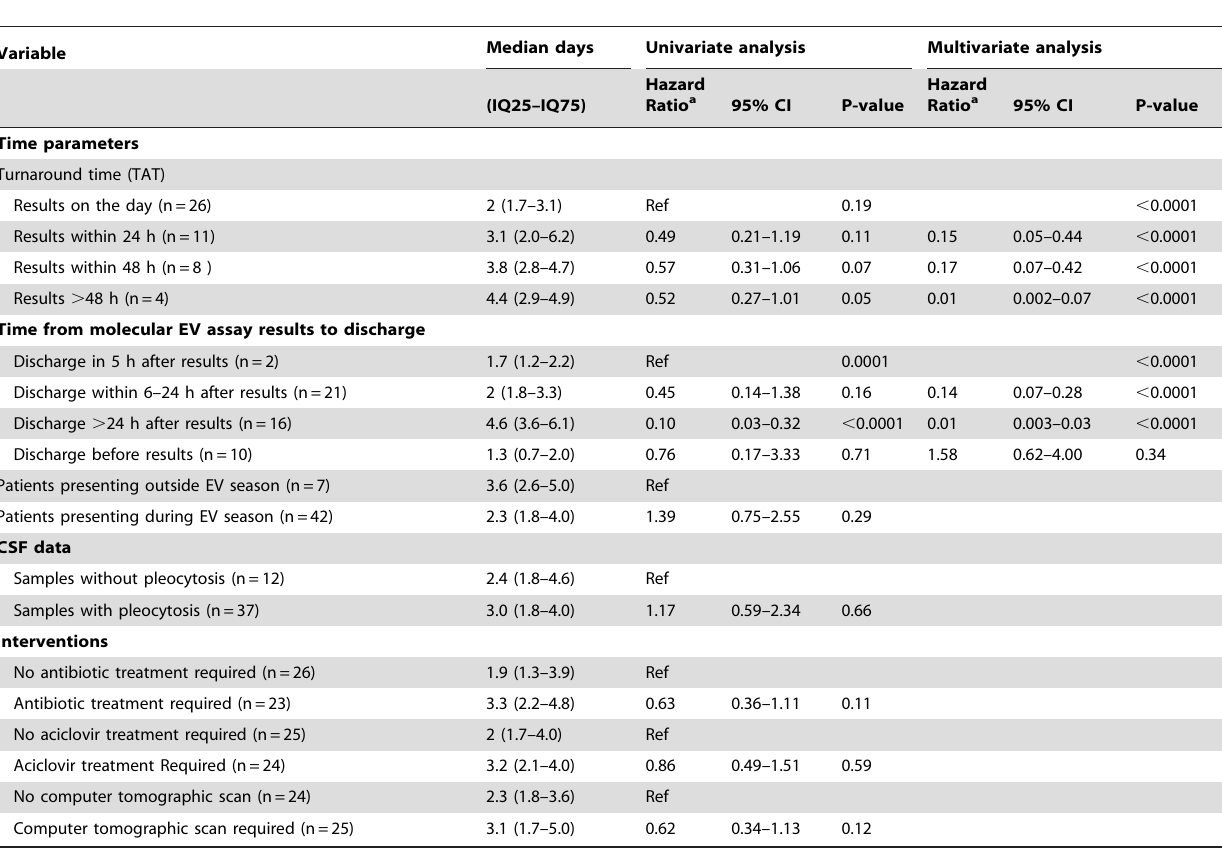
Table 4. Univariate and multivariate analysis of factors associated with hospital length of stay in adults (n=49) with enterovirus (EV) meningitis during the two study periods